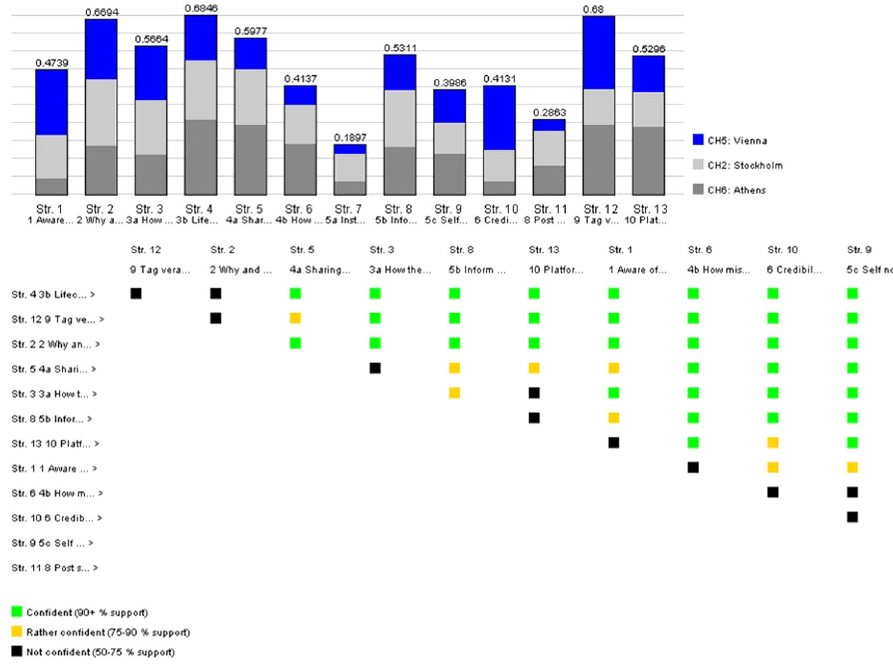
Fig. 2 Citizen preferences in Sweden, Greece and Austria. Preferences.